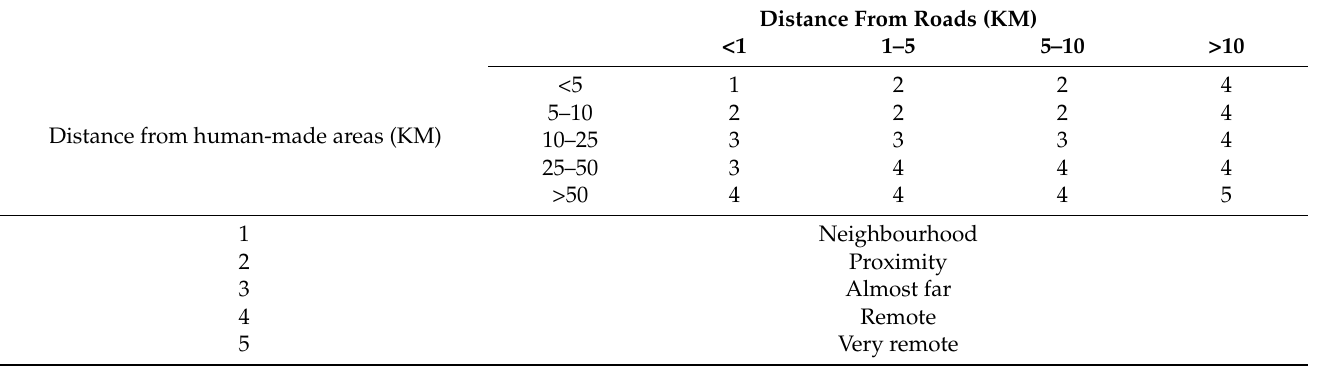
Table A1. Remoteness/accessibility (proximity) parameters.